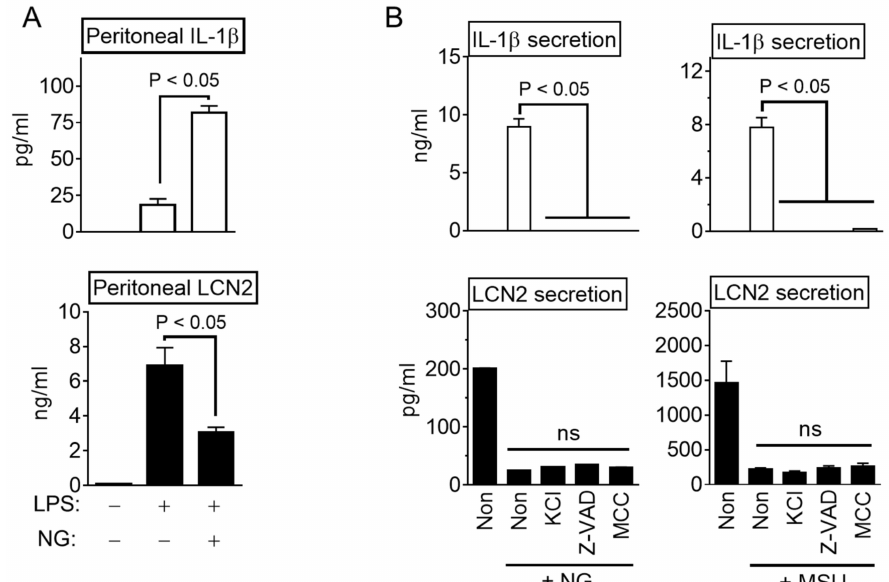
Figure 2. LCN2 secretion and the effect of inflammasome inhibitors on LCN2 secretion. ( A ) Mice (six mice/group) were ip injected with LPS 5 h before the NG treatment and then sacrificed 1 h after NG injection. Peritoneal lavages subjected to IL-1 β and LCN2 ELISA. ( B ) LPS-primed BMDM were treated with NG or MSU, an NLRP3 trigger, and the secretion of IL-1 β and LCN2 in the cellular supernatants were analyzed by ELISA. The bar graph indicates the mean ± SD with at least two independent experiments. ns, not significant.